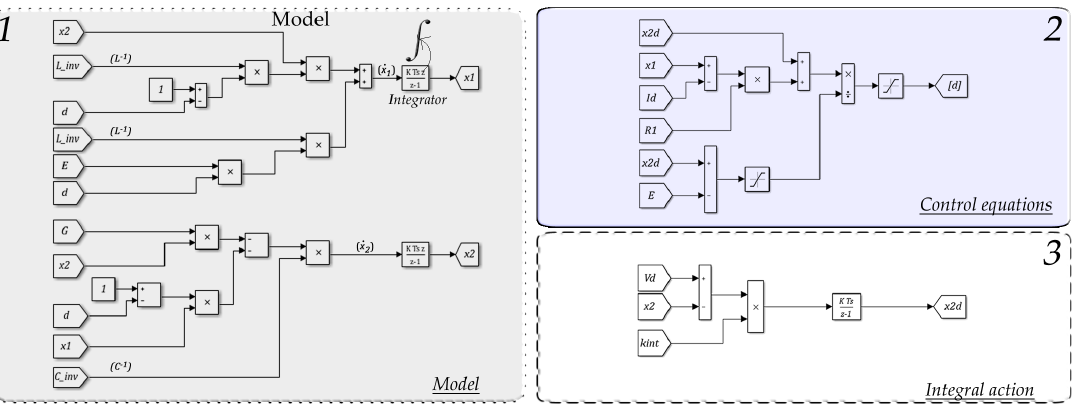
Figure 8. Buck-boost model and SFL control equations in block diagrams. Model (1), control Equation (2) and integral action